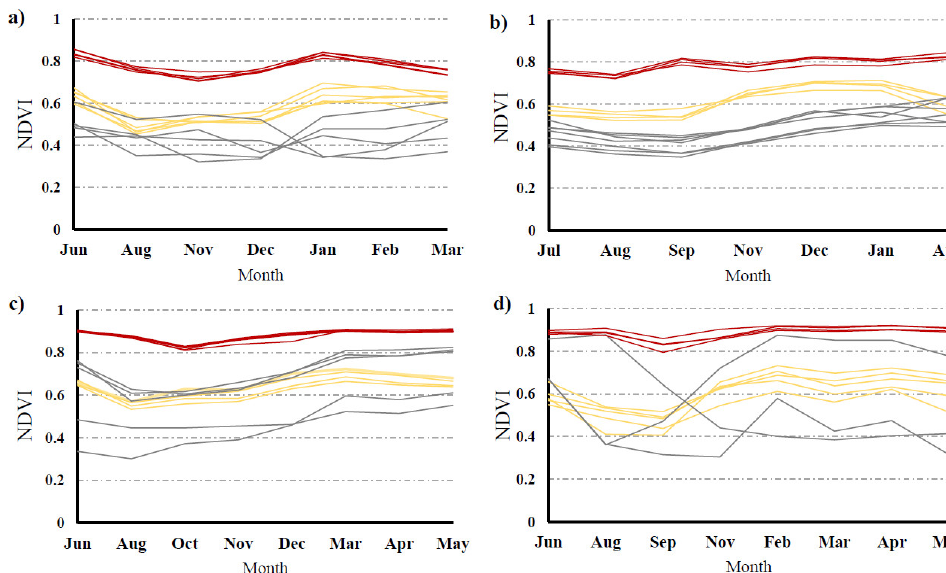
Figure A1. Example of phenological signatures of the outcoming classes obtained from ISODATA unsupervised classification for the Aguapey VGA in ( a ) 1999–2000, ( b ) 2006–2007, ( c ) 2014–2015 and ( d ) 2019–2020. Yellow lines represent grassland covers, red lines represent tree plantation covers (red lines), and grey lines represent other covers. Spectral signatures were randomly obtained from several regions of interest across the study area.